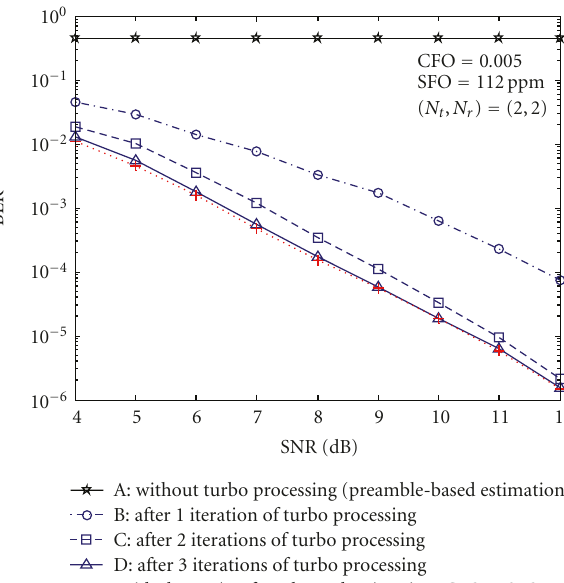
Figure 8: BER performance of the proposed turbo joint channel estimation, synchronization, and decoding